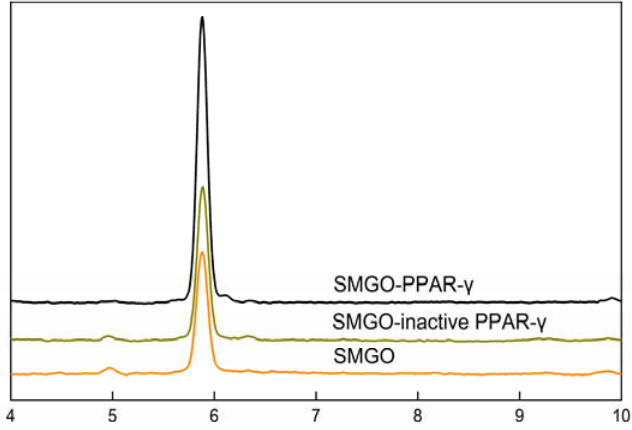
Figure 3. The HPLC chromatograms of rosiglitazone of ligand fishing assay eluent by SMGO-PPAR- γ SMGO-inactive PPAR- γ , and SMGO. Conditions: column: reversed phase symmetry C 18 (250 mm × 4.6 mm i.d., 5 µ m); mobile phase: NH 4 Ac in water (0.01 mol/L, pH = 6)-acetonitrile = 1:1; flow rate: 0.8 mL/min; column temperature: 35 ◦ C; detector wavelength: 247